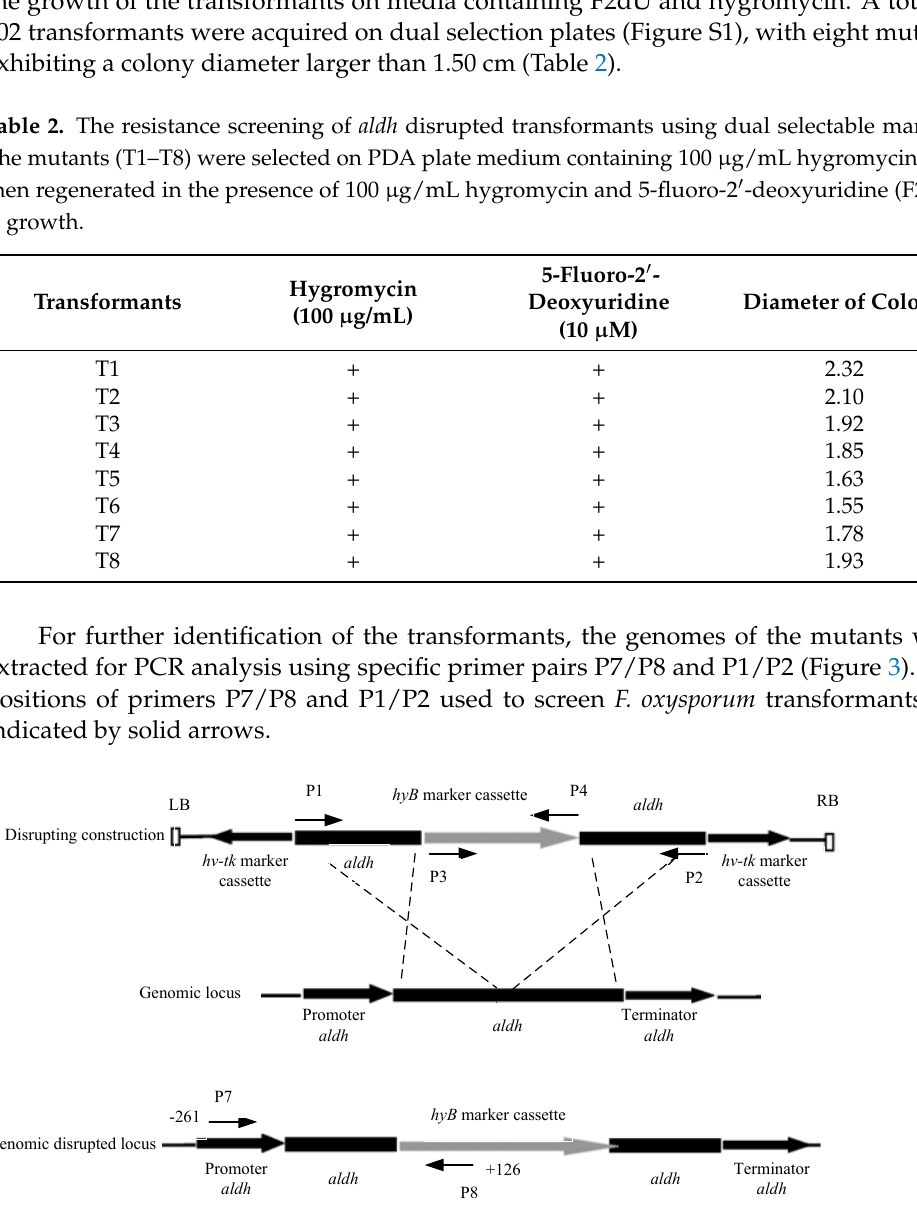
Figure 4. PCR amplification of wild-type strain and transformants. Two transformants, T1 (lanes 1 and 5) and T2 (lanes 2and 6), and wild-type strain (lanes 3 and 4) were firstly screened by PCR with specific primers P1and P2 (lanes 1–3) and then confirmed with primers P7 and P8 (lanes 4–6). M1: Marker 4500; M2: Marker 2000.